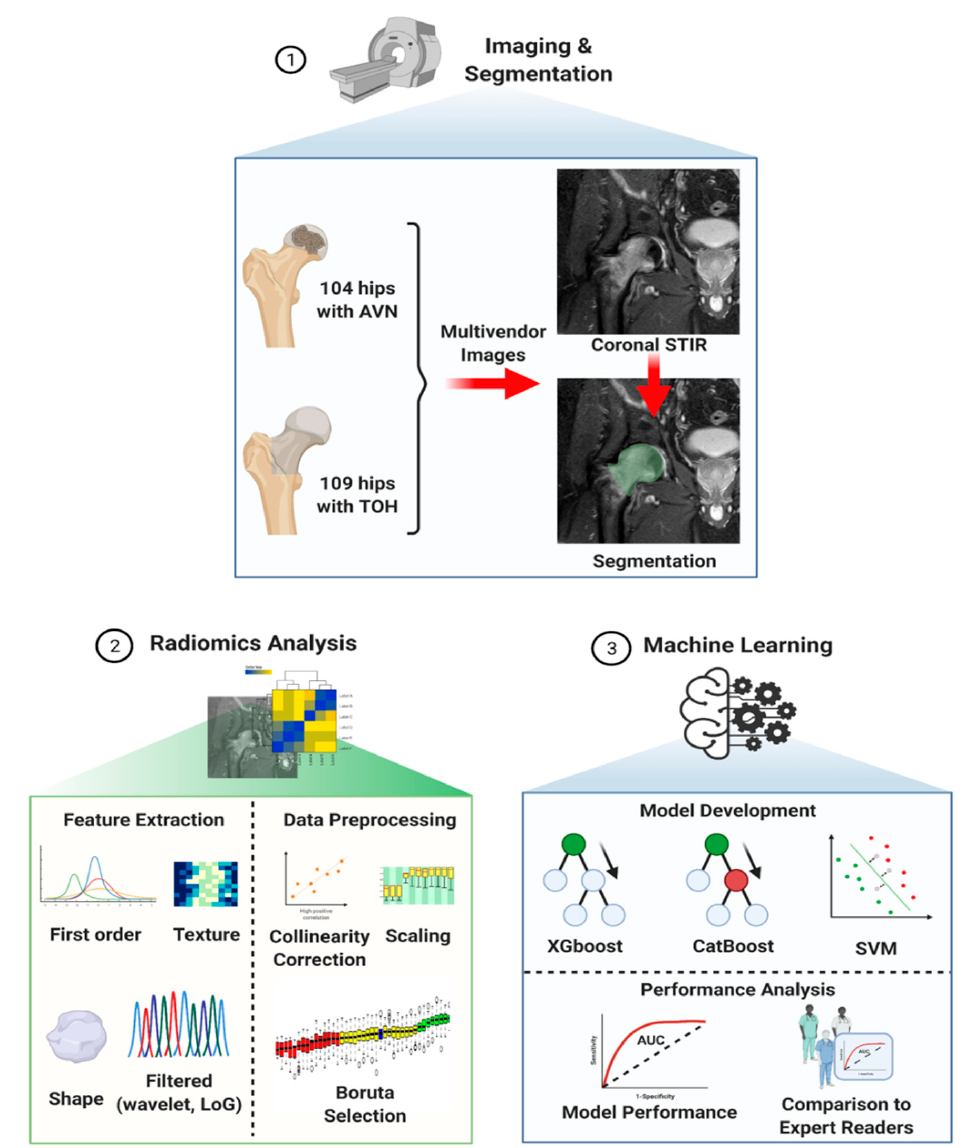
Figure 2. Computational pipeline for radiomics analysis and machine learning model development. The process starts with image acquisition and segmentation of the femoral head and neck (1) followed by radiomics analysis (2) consisting of feature extraction and data preprocessing in preparation for subsequent model development (3). Three machine learning algorithms (XGboost, CatBoost and SVM) were trained and validated with multivendor data and their performance was compared to that of expert readers. TOH: Transient Osteoporosis of the Hip; AVN: Avascular Necrosis; STIR: Short Tau Inversion Recovery; LoG: Laplacian of Gaussian; SVM: Support Vector Machine (created